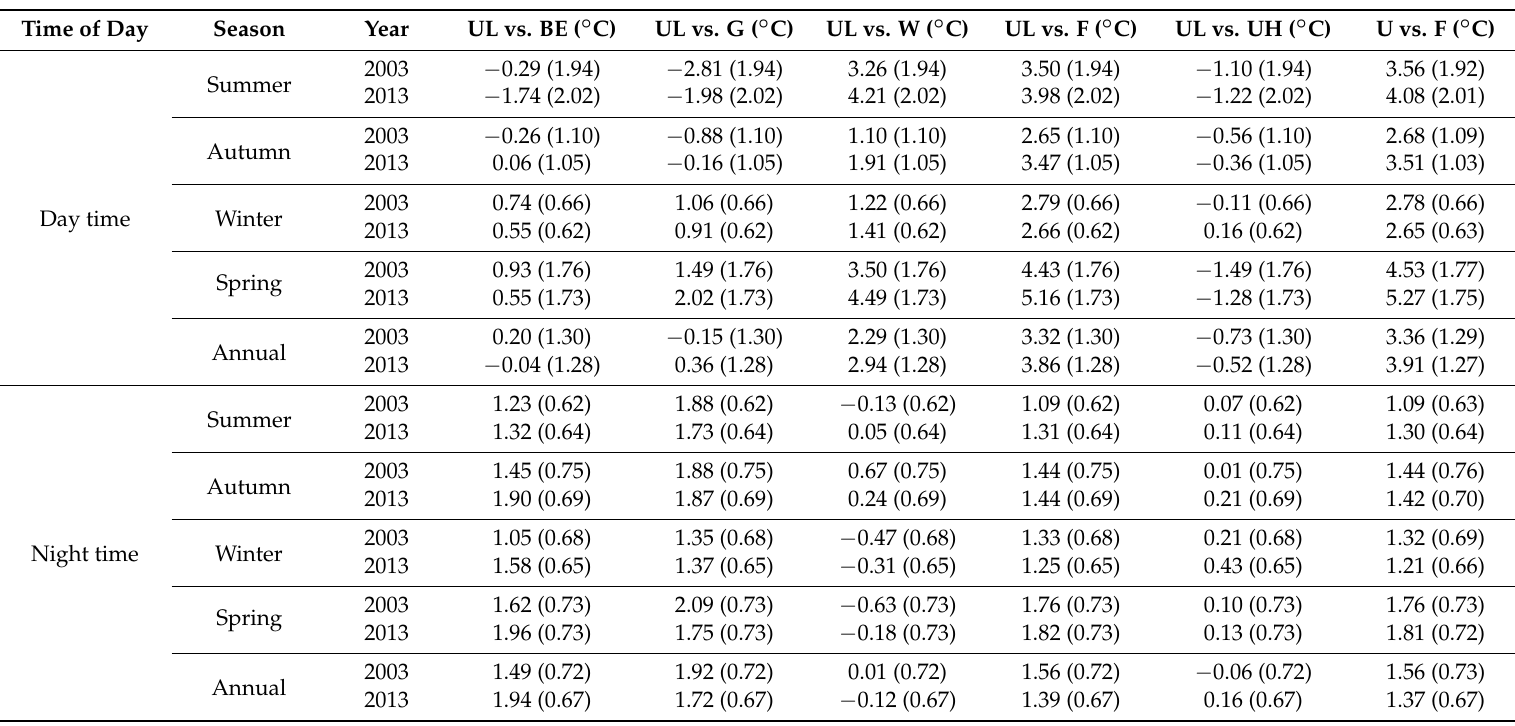
Table 1. Day and night time SUHII and standard deviation (in brackets) between Low Urban albedo (UL) and land cover classes: Bare Earth (BE), Grassland (G), Water (W), Forest (F) and High Urban albedo (UH). Combined urban of both Low and High urban albedo (U) was also separately compared to Forest (F). Time of